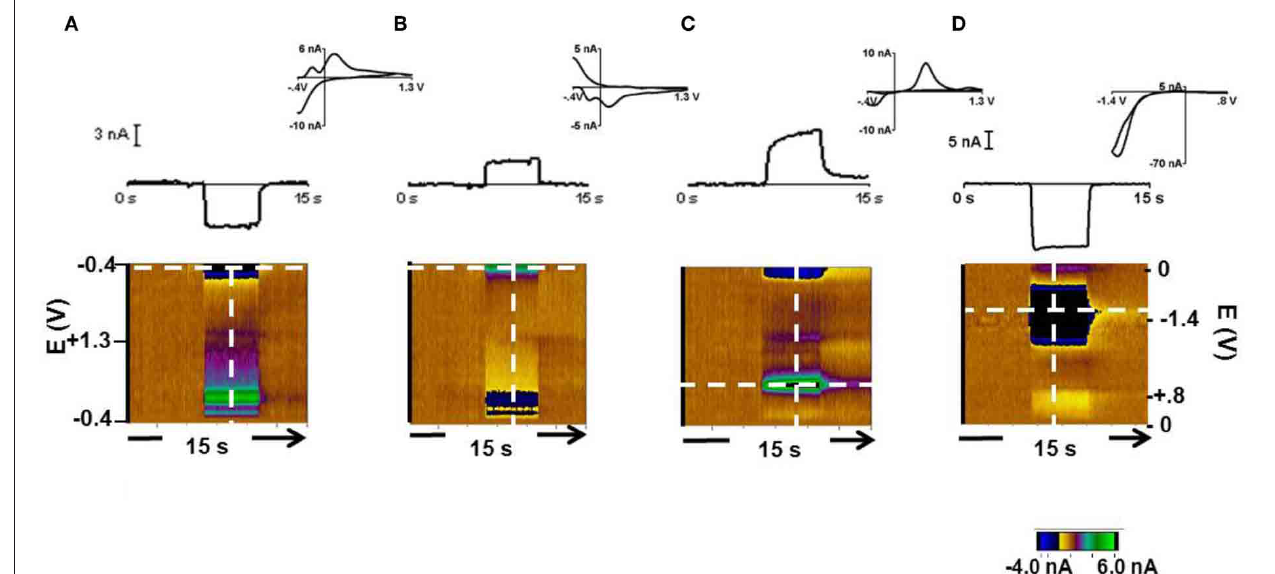
FIGURE 1 | Cyclic voltammetric responses of pH, dopamine and oxygen with a 12 µ m carbon-fiber electrode. The cyclic voltammograms (top, inset), the current during the 15s injection at the peak potential of interest (middle) and the color plots are shown. The color plot shows all changes in current (in false color, greens are positive changes, blues are negative changes) at the applied potentials (y-axis) over time (x-axis) (Michael et al., 1998) (A) . Response during exposure to a 0.3pH acidic change. Current was